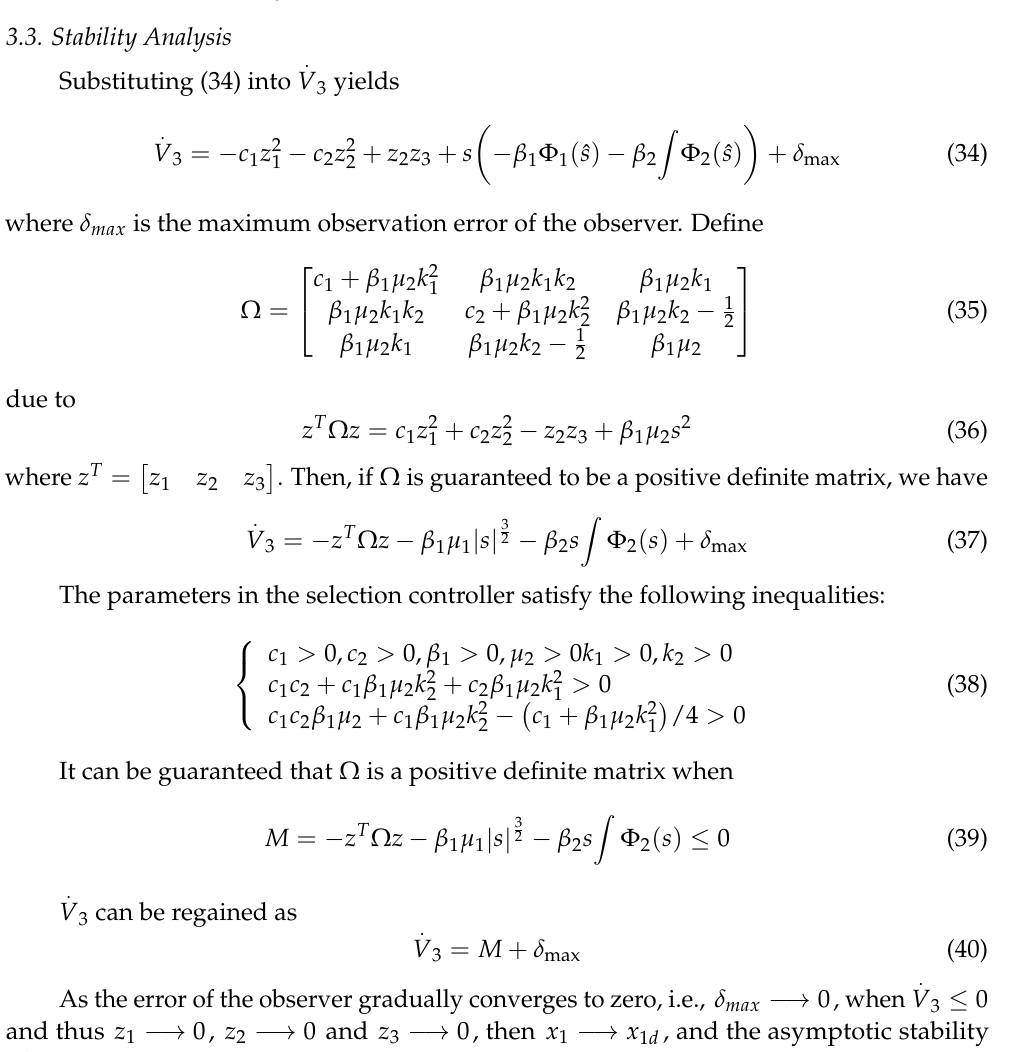
Figure 2. Overall block diagram of the